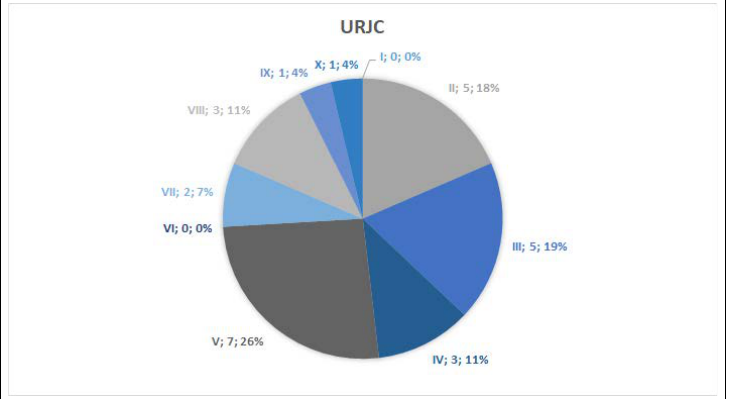
Figure 8. Answers to question 4 What was not clear to you? given by URJC